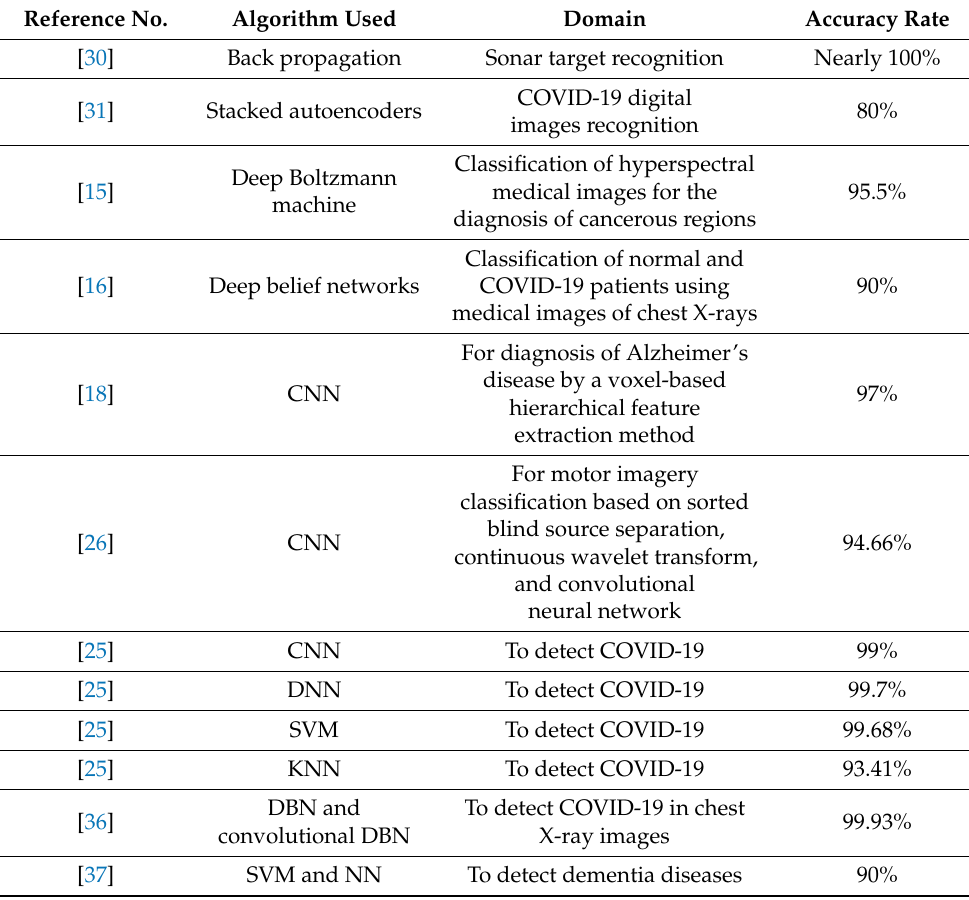
Table 1. Deep learning algorithms used in different domains with